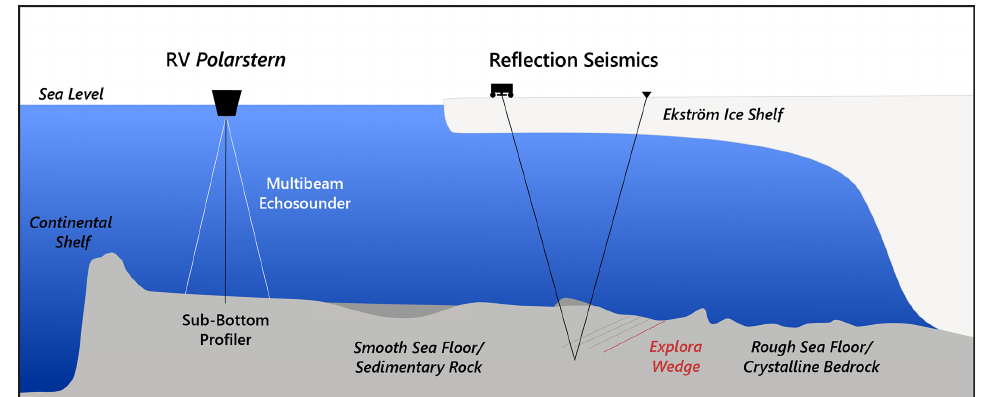
Figure 2. Schematic display of the study area and the used methods. The shown features are not to scale.